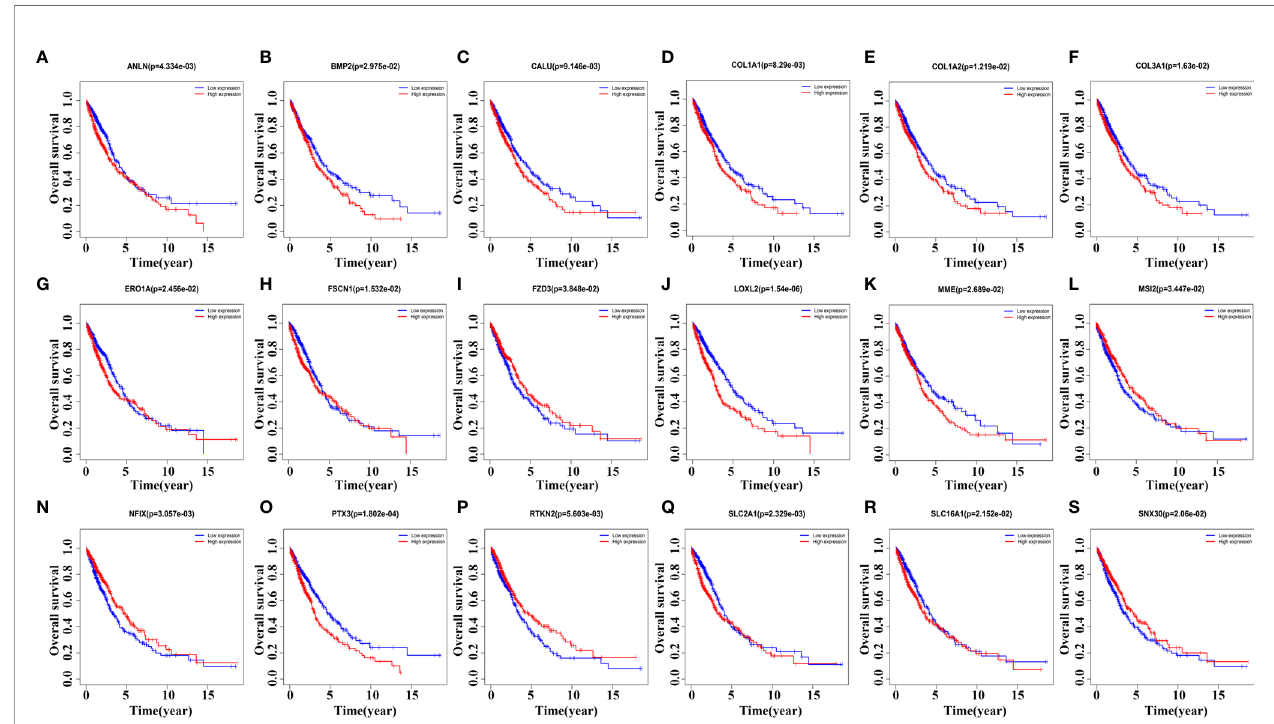
FIGURE 7 | Kaplan-Meier survival analysis screens prognostic factors in the ceRNA network. (A) ANLN; (B) BMP2; (C) CALU; (D) COL1A1; (E) COL1A2; (F) COL3A1; (G) ERO1A; (H) FSCN1; (I) FZD3; (J) LOXL2; (K) MME; (L) MSI2; (N) NFIX; (O) PTX3; (P) RTKN2; (Q) SLC2A1; (R) SLC16A1; (S)